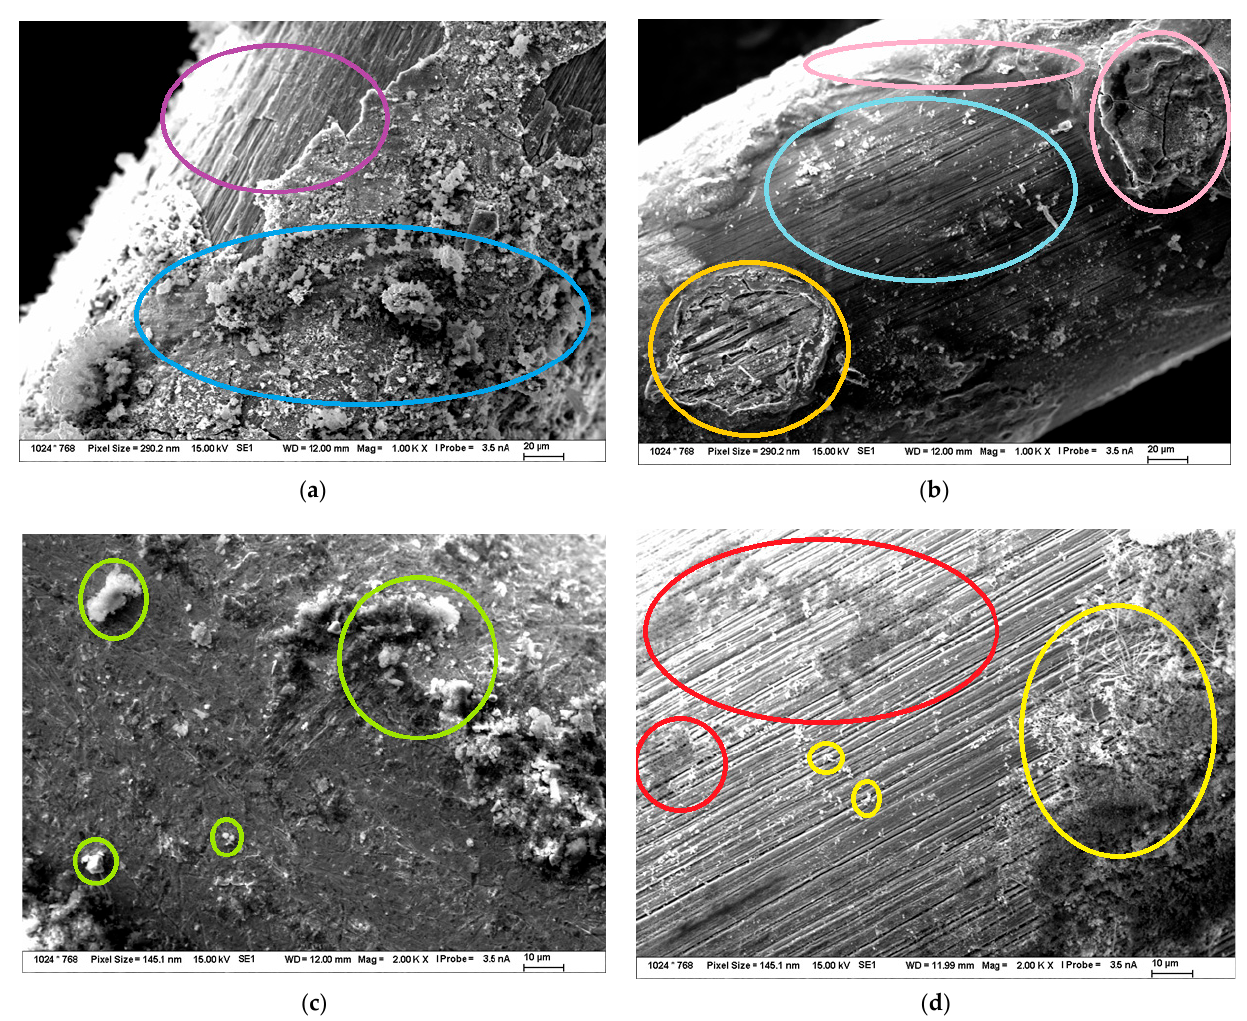
Figure 5. SEM images of the fiber surface used for composite fabrication ( a ) HNO 3 ( b ) HCl ( c ) Mechanical treatment ( d ) NH 3 /H 2 O 2 .